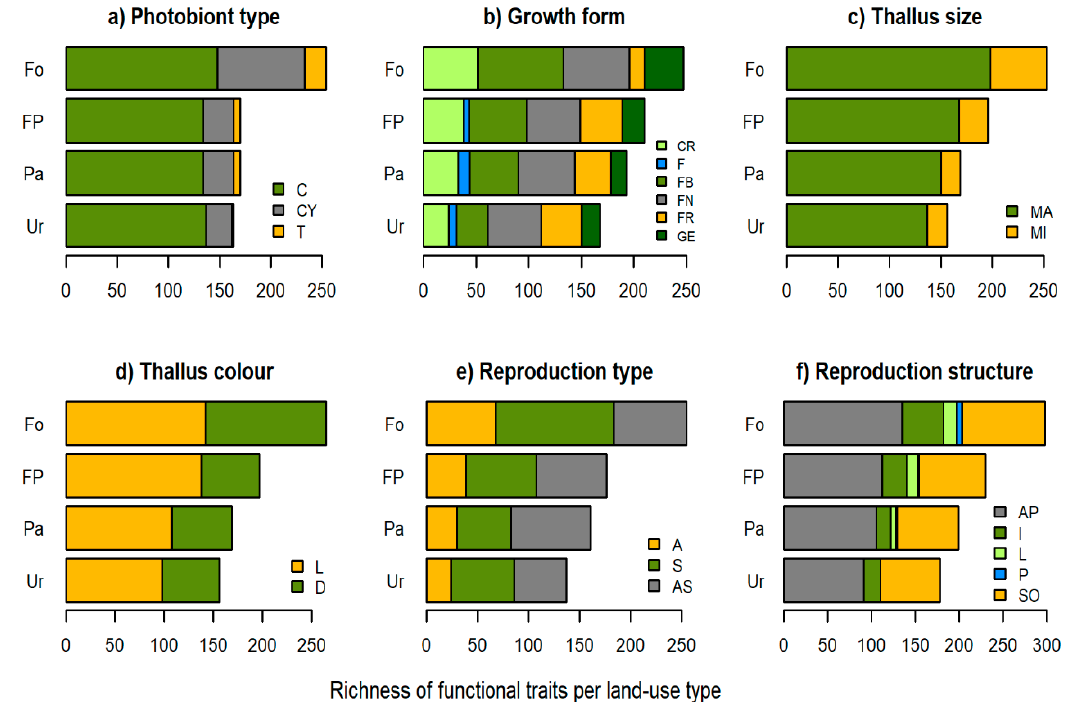
Figure 4. Variation in the richness of functional traits of the epiphytic lichen community in four riparian land uses of Andean streams in southern Ecuador. Functional trait and categories evaluated are indicated as follows. Photobiont type ( a ): C = Chlorococcoid; CY = Cyanobacteria: T = Trentepholia . Growth form ( b ): CR = Crustose; F = Filamentose; FB = Foliose with broad lobes; FN = Foliose with narrow lobes; FR = Fruticose; G = Gelatinose. Thallus size ( c ): MA = Macrolichens; MI = Microlichens. Thallus color ( d ): L = Light; D = Dark. Reproduction type ( e ): A = Asexual; S = Sexual; AS = Asexual and sexual. Reproductive structure ( f ): AP = Apothecia; I = Isidia; L = Lirellae; P = Perithecia; SO = Soredia. Fo = Forest; FP = Forest Pasture; Pa = Pasture; y Ur = Urban.